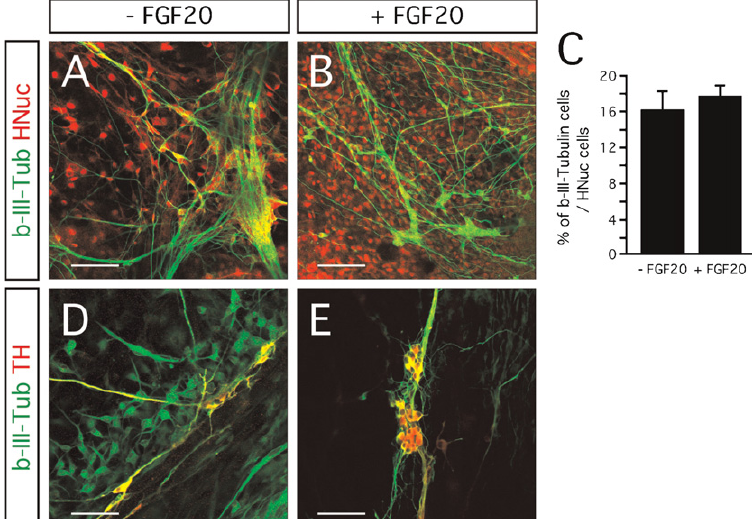
Figure 3. Effect of FGF-20 on neuronal differentiation. ( A , B ) Representative images of b-III-Tubulin- and HNuc-positive cells in 3 weeks differentiated hESCs/ PA6 co-cultures (cid:2) FGF-20 (A) and þ FGF-20 (B). ( C ) Graphic representation of the percentages of b-III-Tubulin-positive cells among HNuc-positive cells in 3 weeks differentiated hESCs/PA6 co-cultures (cid:2) FGF-20 and þ FGF-20. Average (cid:1) SEM. ( D , E ) Co-localization of b-III-Tubulin and TH in 3 weeks differentiated hESCs/PA6 co-cultures (cid:2) FGF-20 (D) and þ FGF-20 (E). Distance bars: A, B, D, E: 100 m m.